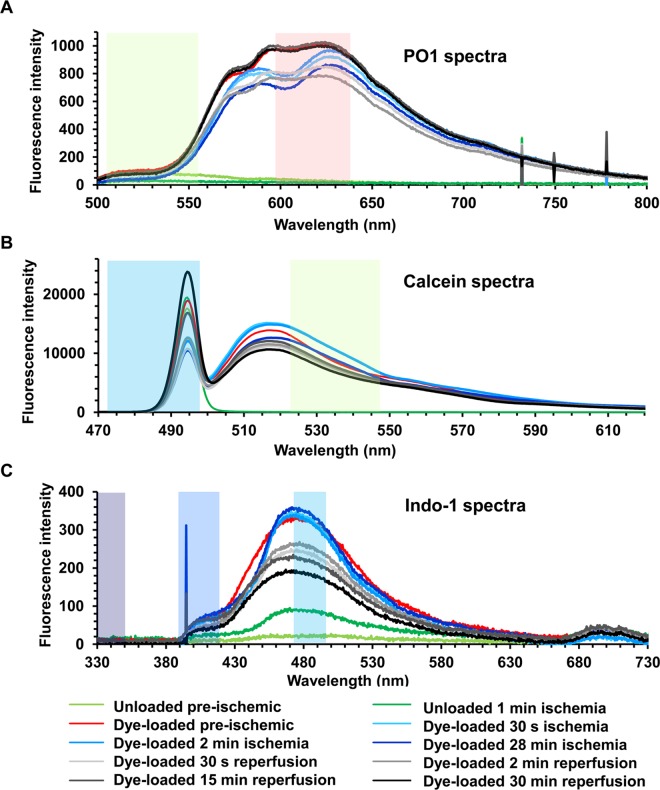
Surface fluorescence spectra of hearts at different stages of dye loading and ischemia-reperfusion protocols.A, PO1 perfused hearts; B, Calcein loaded hearts; C, Indo-1 loaded hearts. The coloured shaded areas indicate the band passes of the filters used for excitation and emission in the filter wheel mode of operation (see S1 Table for details).